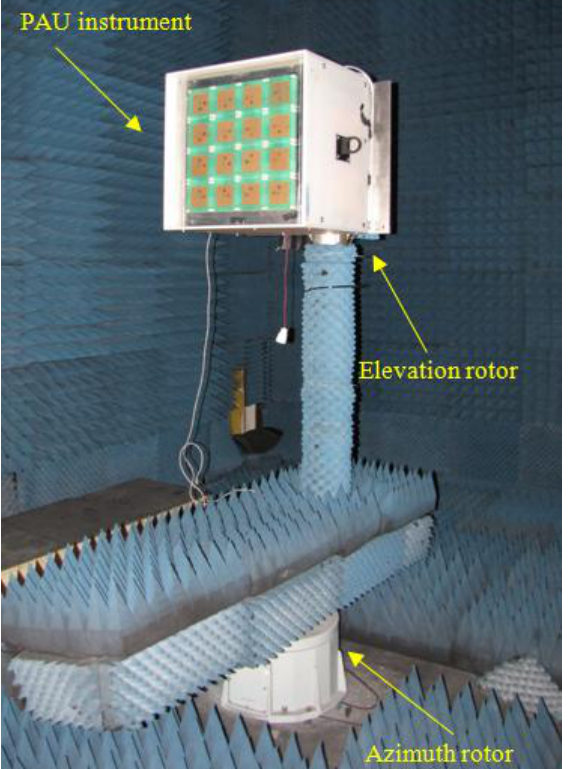
Figure 14. UPC anechoic chamber [29] set up for measuring the PAU-RAD